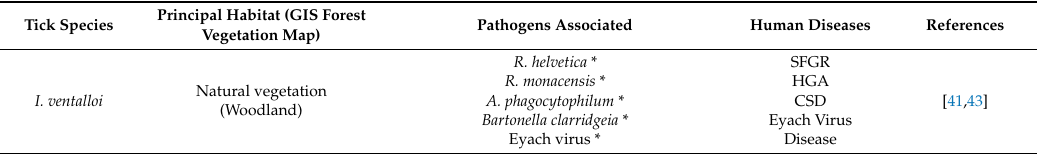
Table 3. Principal habitat for each tick species found in this study with reference to associated pathogens/human